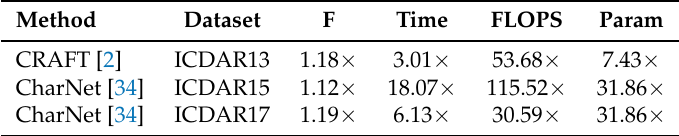
Table 4. Comparison the CAST with the most accurate models for each dataset, where F indicates F1 score, and K × means that the corresponding model is relatively K times better or worse than the CAST.